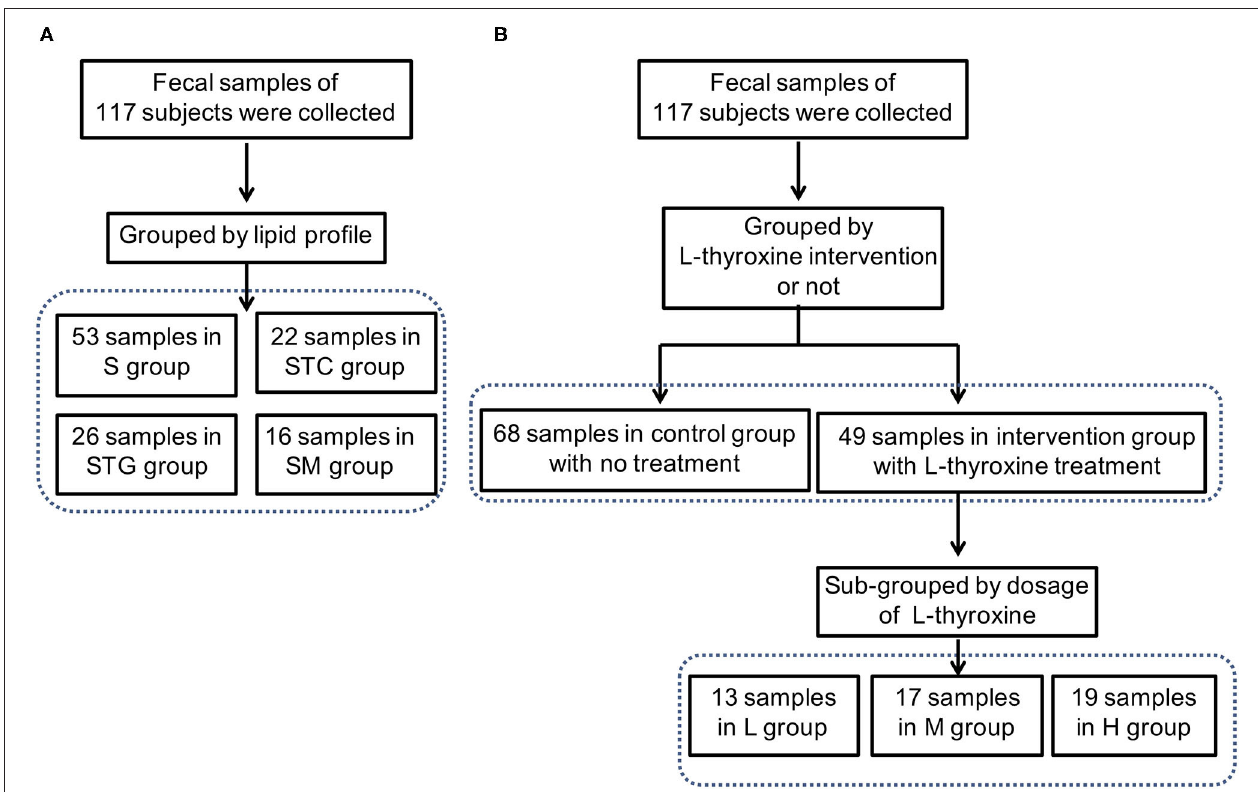
FIGURE 1 | Trial profile. (A) All subjects were divided into the STG [subclinical hypothyroidism (SCH) with high serum triglyceride level] group, STC (SCH with high serum cholesterol level) group, SM (SCH with both high serum triglyceride and cholesterol level) group, and S (SCH with normal serum lipid profile) group according to the guidelines of Chinese adult dyslipidemia prevention and treatment (2016 edition). (B) All subjects were divided into L-thyroxine replacement therapy (LRT) group and NC group. In addition, subjects in LRT group were manually subdivided into low dose (L) group, middle dose (M) group, and high dose (H) group based on the doses of L-thyroxine.